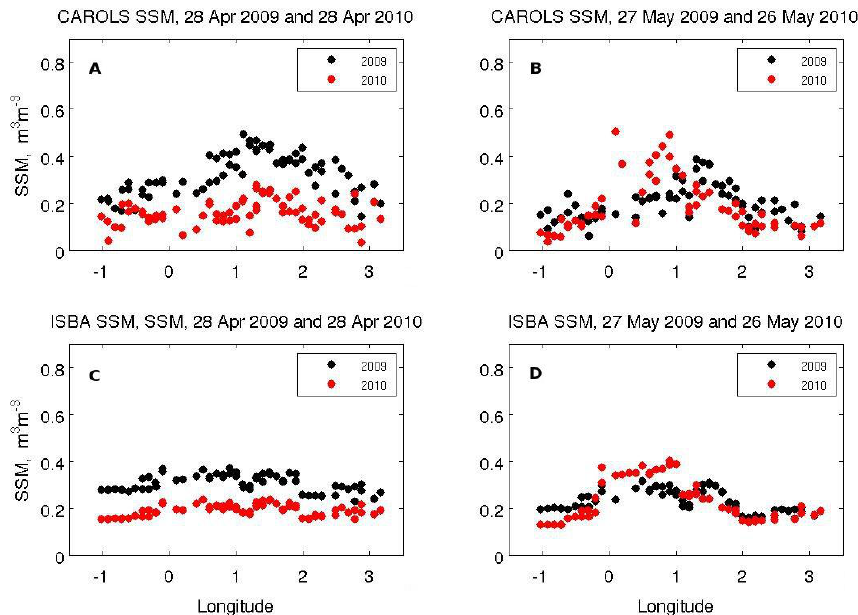
Fig. 6. Flight transect of the surface soil moisture from (A, B) CAROLS retrievals and from (C, D) ISBA-A-gs simulations, at (A, C) the end of April 2010, and (B, D) the end of May